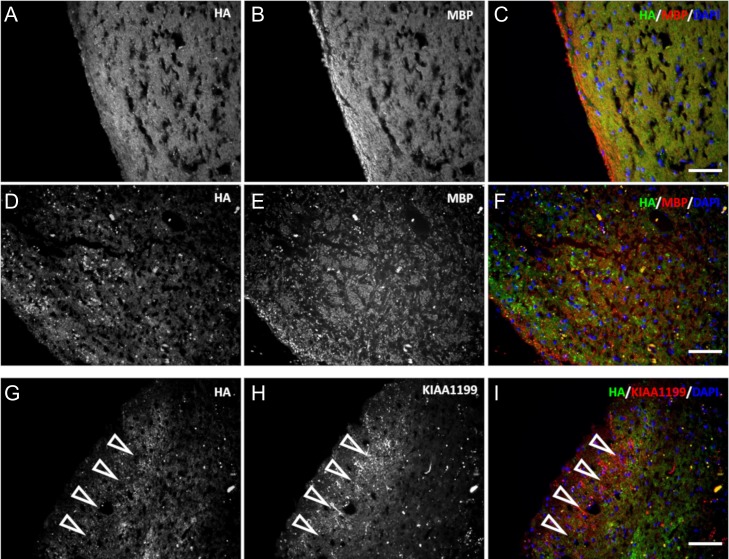
KIAA1199 protein is localized within areas of lesions depleted of HA. Tissue sections from a control patient (A–C) or an MS patient (D–I) were colabeled for HA (A, D, G) and myelin basic protein (MBP) (B, E) or KIAA1199 (H). (C) and (F) are the merged micrographs that display HA (green), MBP (red) and the nuclei DAPI counterstain (blue). (I) is the merged micrograph of the MS patient sample that displays HA (green), KIAA1199 (red) and the nuclei DAPI counterstain (blue). HA and KIAA1199 labeling were mutually exclusive in the tissue lesions (open arrows; scale bar, 50 μm).